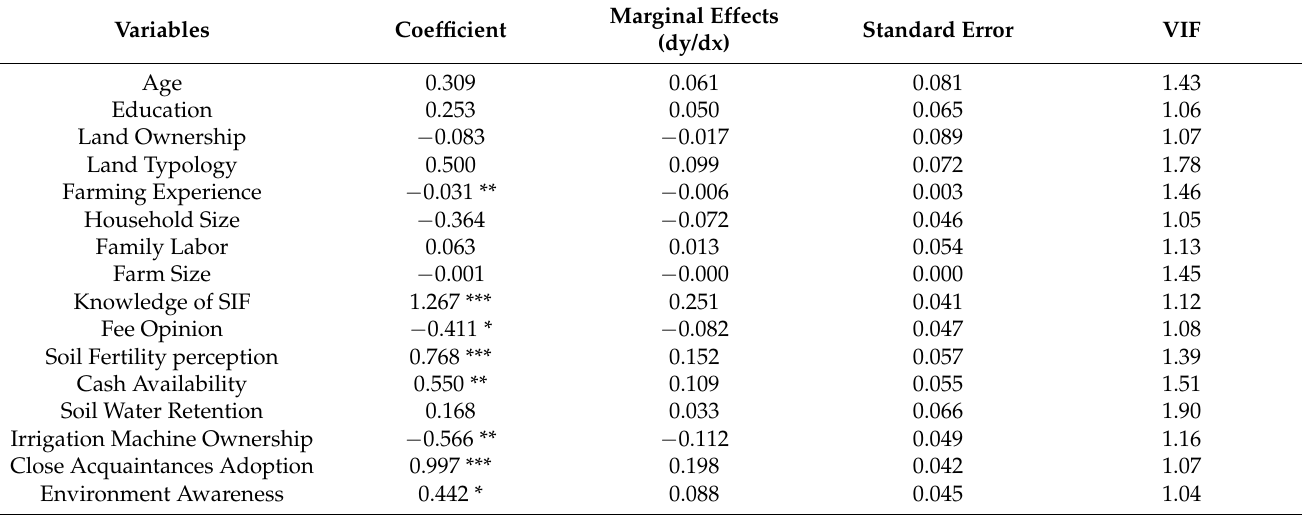
Table 3. Factors affecting the adoption of a solar irrigation